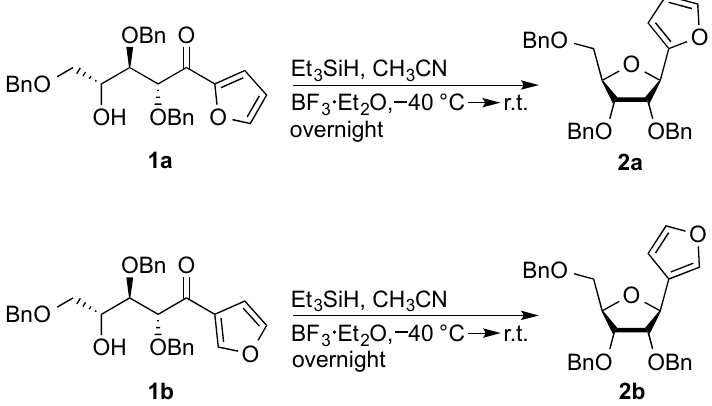
Scheme 1. Stereoselective synthesis of 2- and 3-( β -ribofuranosyl)furans 2a , b